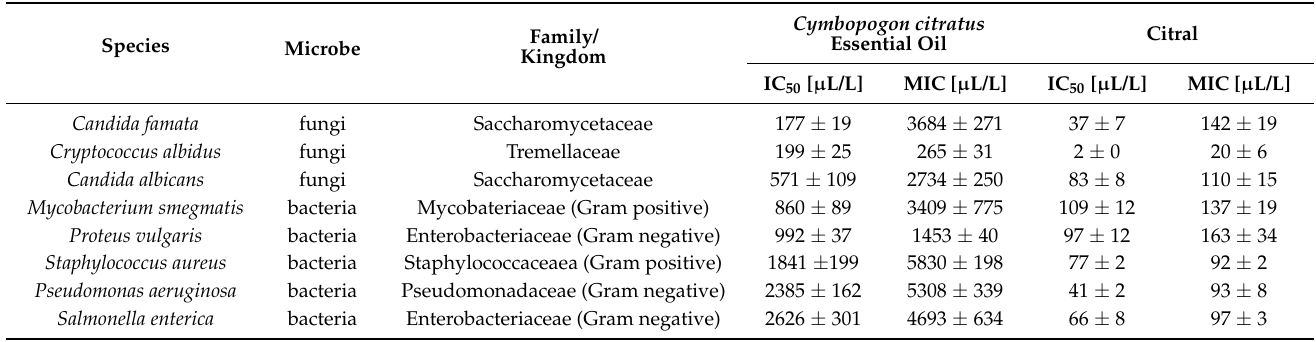
Table 1. Antimicrobial activity of Cymbopogon citratus (DC.) Stapf essential oil and citral. MIC, minimum inhibitory concentration; IC 50 , half maximal inhibitory concentration. Adapted from Viktorov á et al.